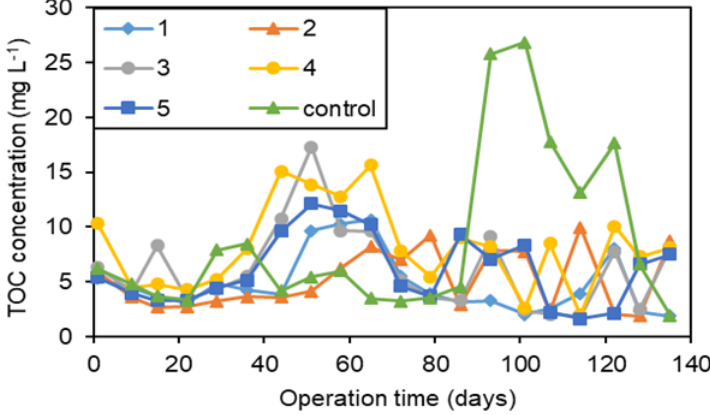
Figure 6. Total organic carbon (TOC) in six columns during the operation